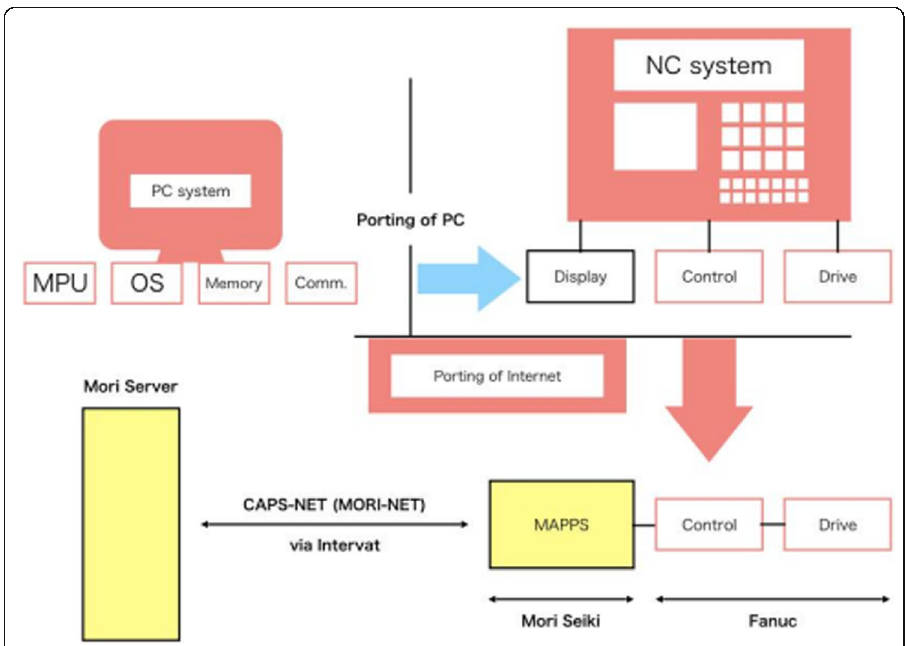
Fig. 9 A new manufacturing architecture is emerging though two steps of porting. Source: Shibata